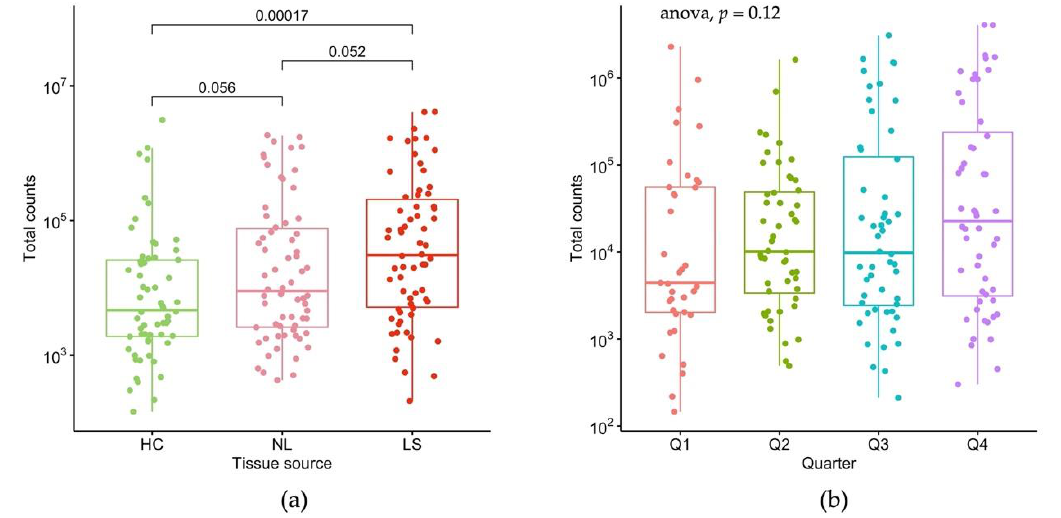
Figure 2. Total count variation. ( a ) The boxplot shows total count having an increasing trend in HC < NL < LS. P -values are shown above the contrasts; ( b ) the boxplot shows that RNA yield varies in different quarters of the year, but the differences did not reach statistical significance ( p = 0.12).